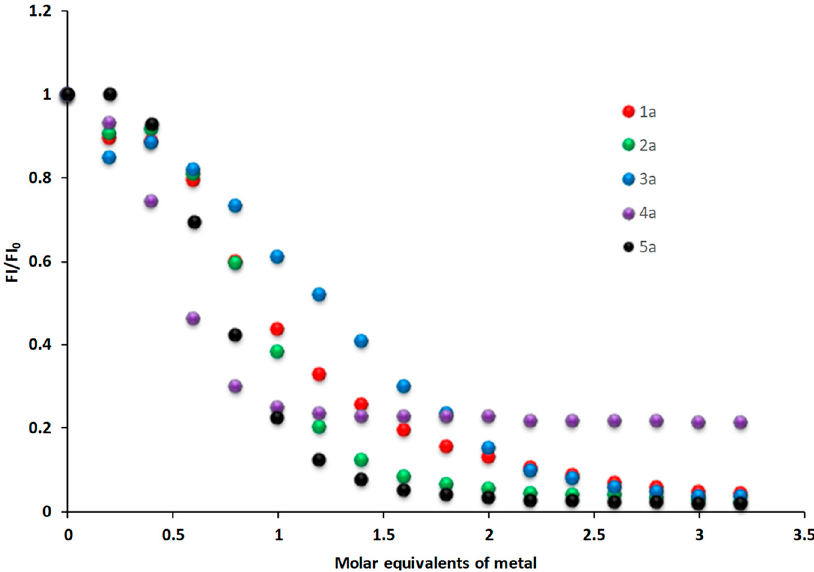
Figure 5. Relative fluorescence profiles obtained with Cu 2 + and derivative 1a – 5a λ ex = 312 nm, λ em = 413 nm.